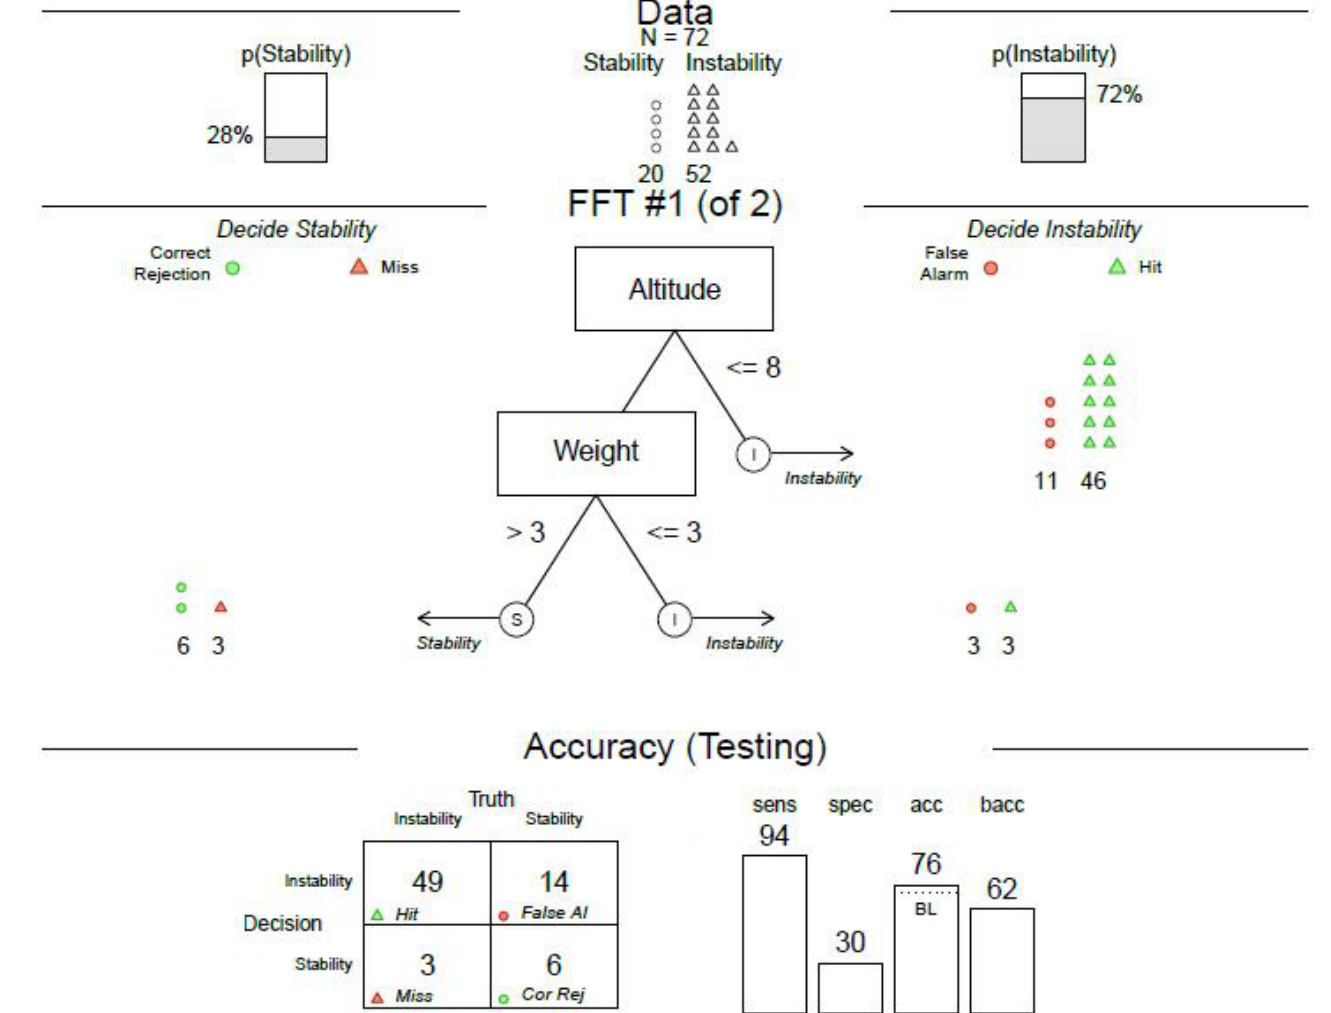
Figure 5. Best tree (upper centre) and performance statistics (bottom) for a testing phase using the remaining 30% of the sample (n = 72). At the bottom, fitting values of the tree model. Abbreviations: sens: sensibility, spec: specificity, acc: accuracy, bacc: balance